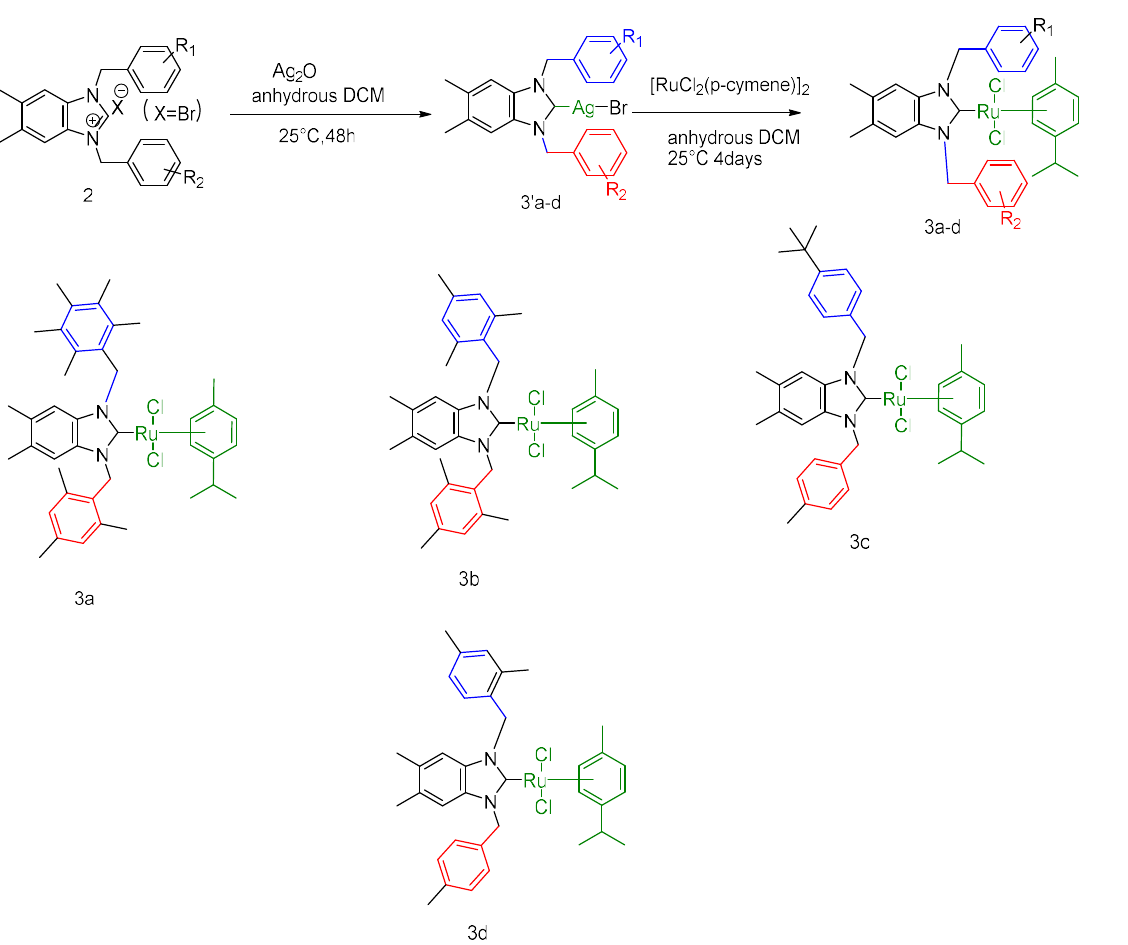
Table 1. Anti-AChRi and anti-TyrEI inhibitory activity of the synthesized compounds IC 50 in µ M mL − 1 of mean ±